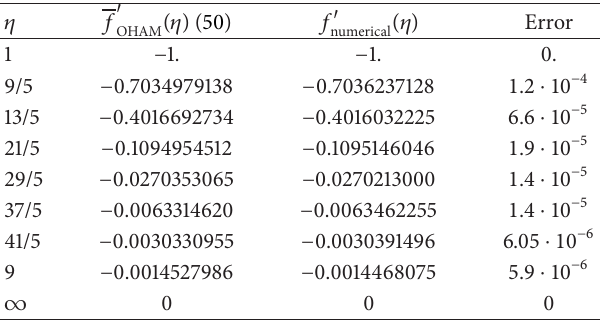
Table 5: Comparison between the derivative 𝑓 (50) and numerical results for 𝛾 = 1 and 𝑆 = −1 (error = |𝑓 (𝜂)| ). 𝑓 󸀠 numerical